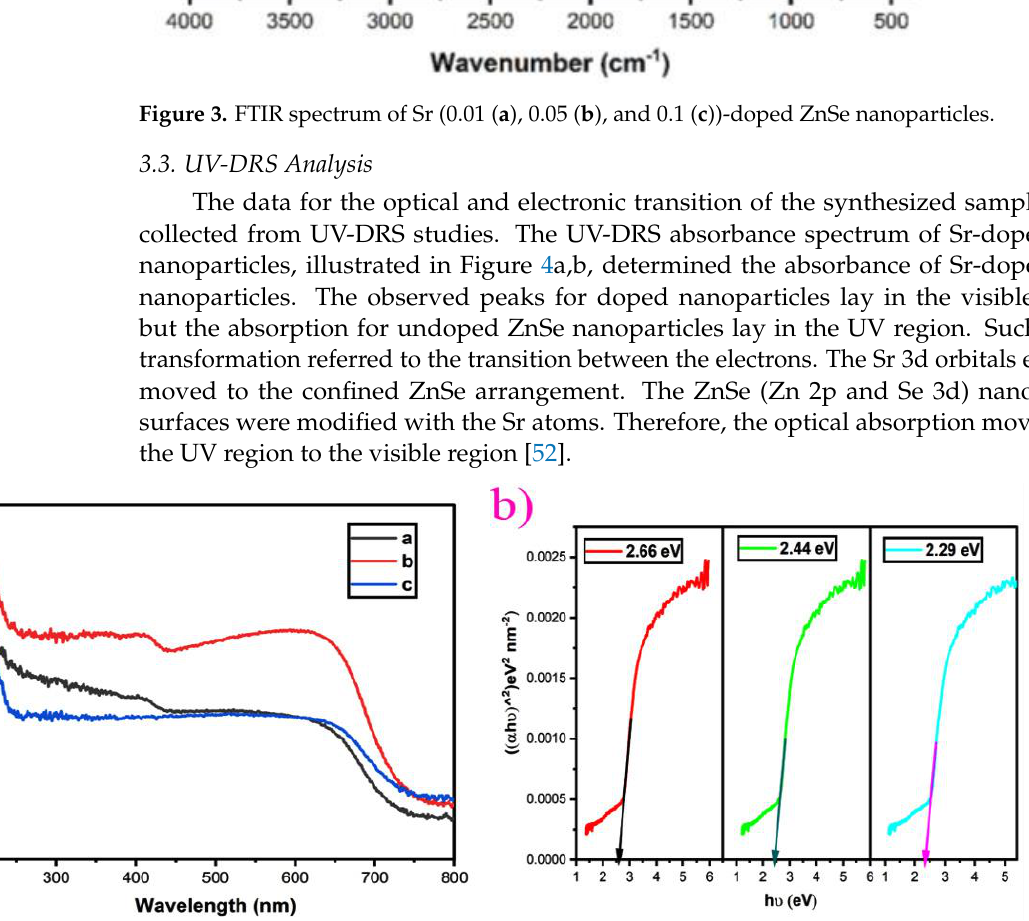
Figure 4- ( a ) UV – Vis DRS spectra and ( b ) bandgap spectrum of the Sr [0.01 (a), 0.05 (b) and 0.1 (c)] doped ZnSe nanoparticles.